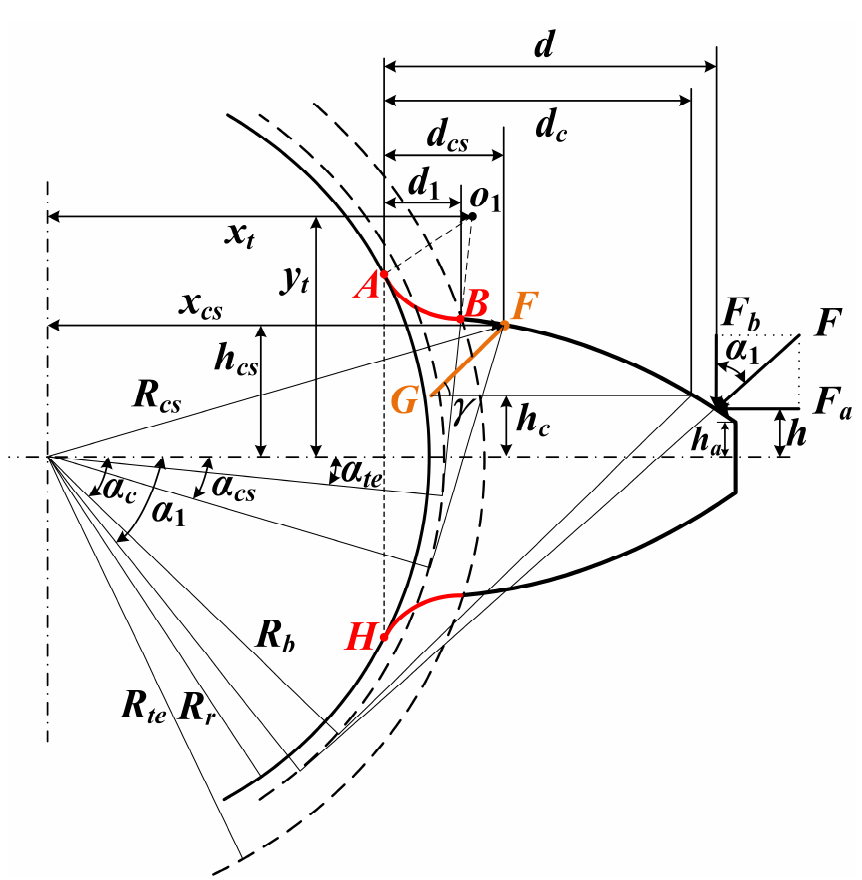
Figure 6. Tooth cracks on the involute part [50] .